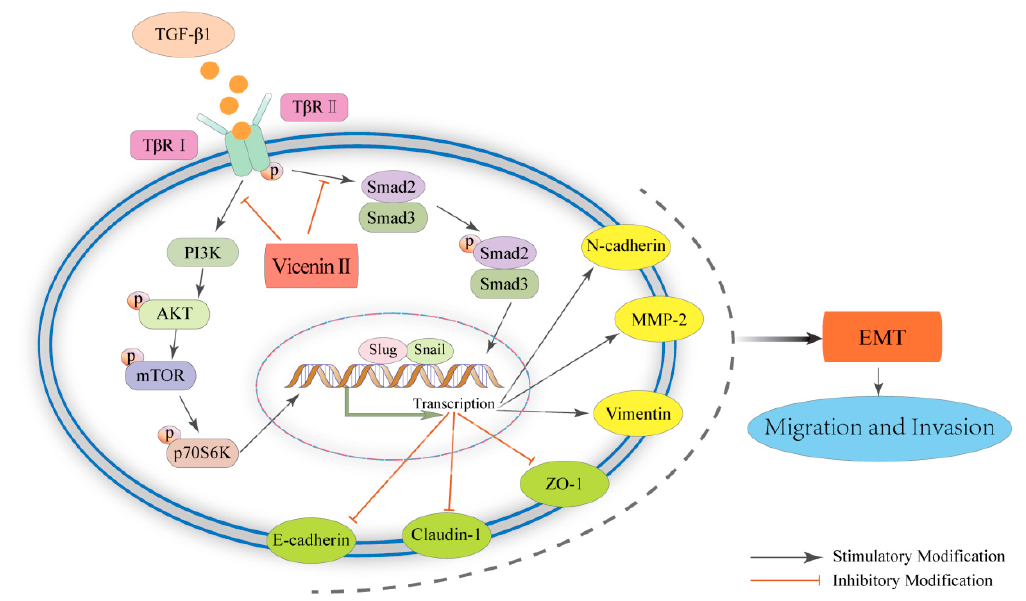
Figure 7. Schematic representation of the effect of Vicenin Ⅱ on TGF ‐β 1 ‐ induced EMT in lung adenocarcinoma A549 and H1299 cells. Vicenin Ⅱ suppressed the PI3K/Akt/mTOR and TGF ‐β /Smad pathways and finally inhibited migration and invasion of lung adenocarcinoma cells by affecting TGF ‐β 1 ‐ induced EMT. “ → ” indicates promotion; “ ⊥ ” indicates inhibition.